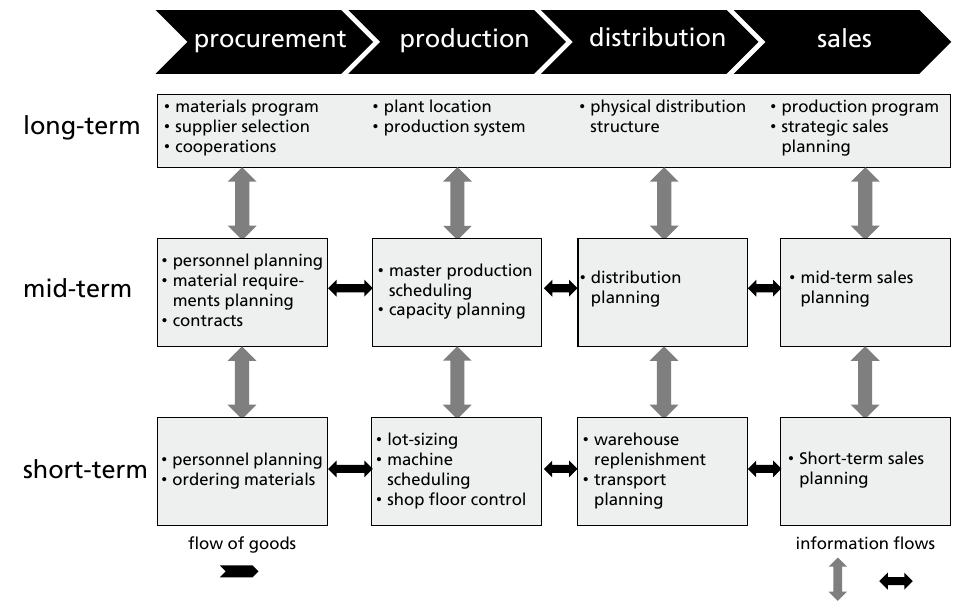
Figure 1. Planning and decision-making tasks in supply networks